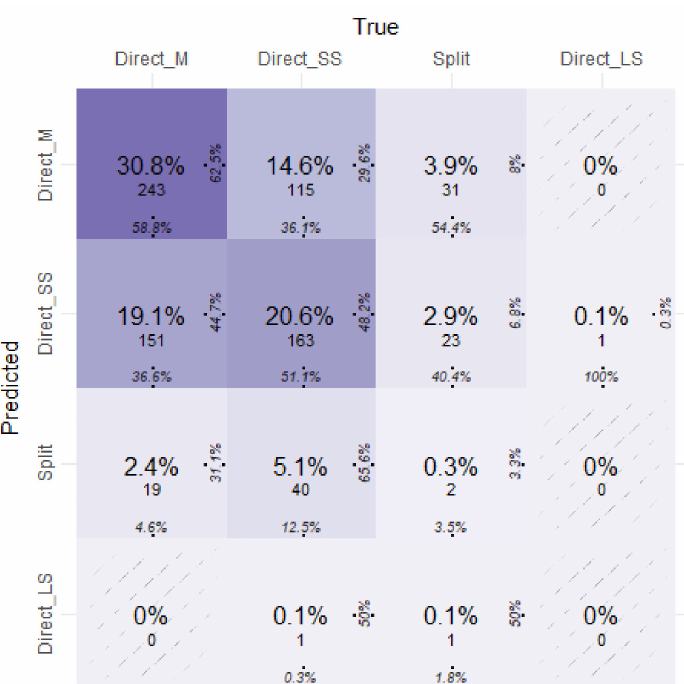
Figure 13. Confusion matrix showing the frequency that each DBH height class was identified by the VBH algorithm (expressed as a percentage with the number of occurrences below) and the percentage that each class was confused with a different class (small percentages), Direct_M is where a measurement was taken at 1.4 m (no swelling), Direct_SS is where the DBH was moved by <10 cm to avoid a small swelling, Split is where a split measurement was used to avoid a large swelling and Direct_LS is where a large swelling was too large to use a split and so a single measurement was taken at <1.4 m.